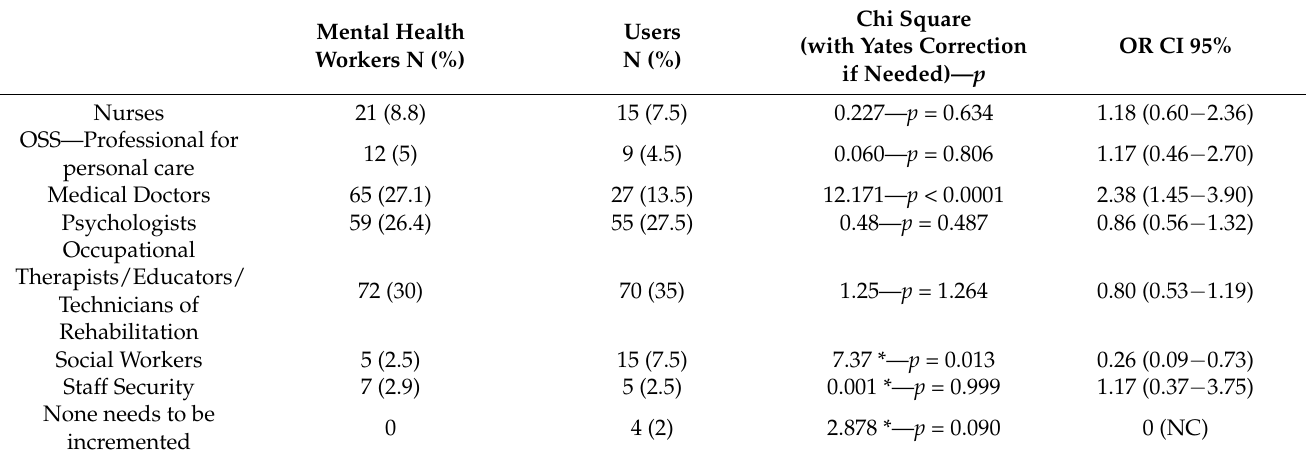
Table 3. Needs for type of health workers in the service in which I work / I’m cared (Item 7